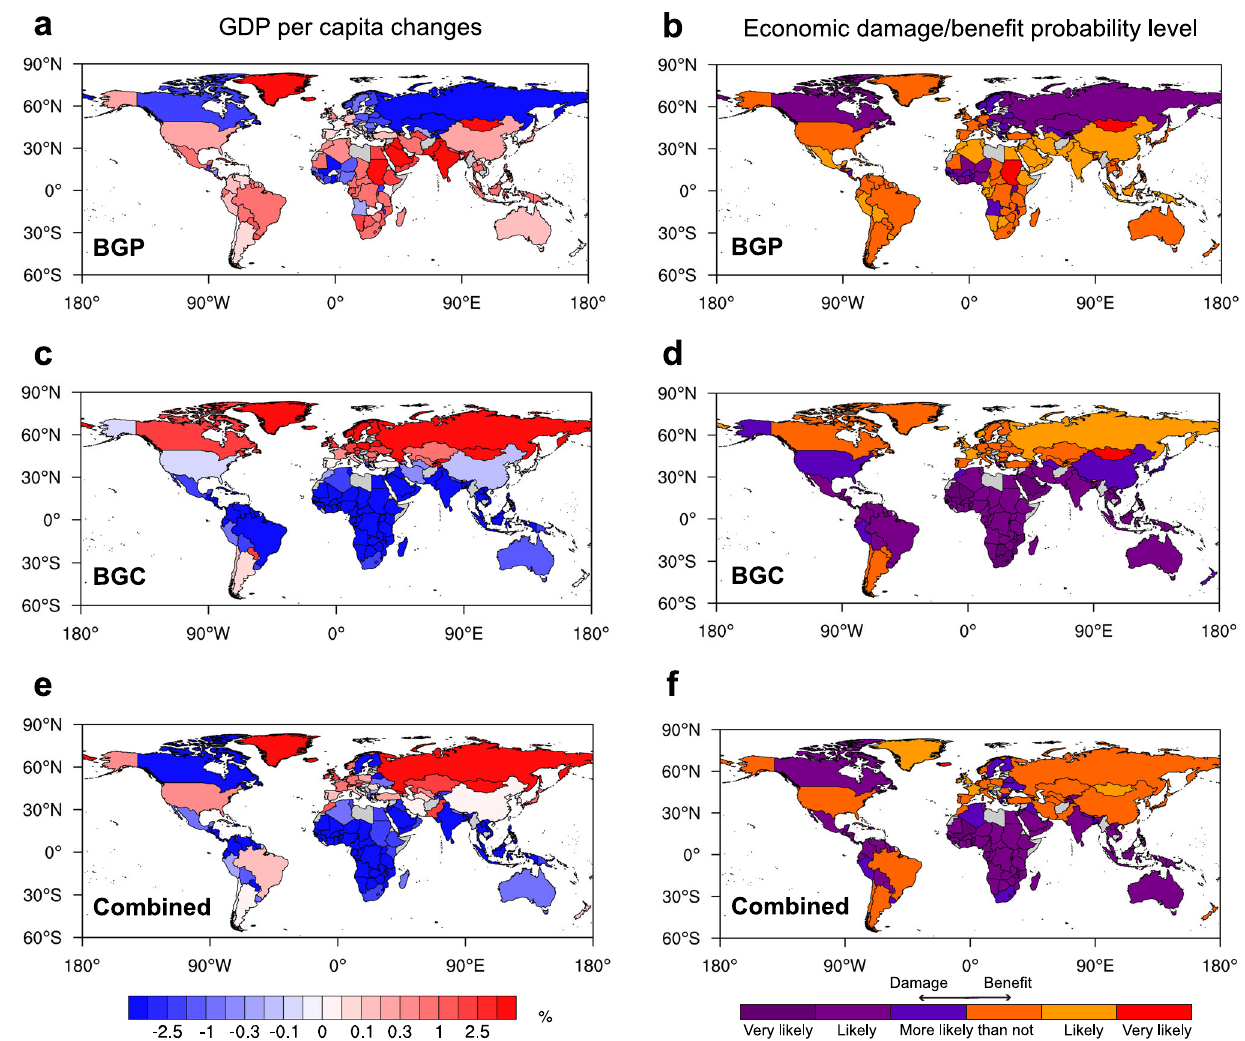
Fig. 5 Country-level cumulative economic impacts via annual-mean surface air temperature (SAT) changes from 1993 to 2012 due to biogeophysical (BGP) and biogeochemical (BGC) impacts of historical land-use and land-cover change (LULCC). a , c , e The ensemble median of the relative changes in GDP per capita (%) in 2012 induced by ( a ) BGP, ( c ) BGC, and ( e ) their combined impacts. b , d , f The corresponding probability level of the economic damage/bene fi t according to the IPCC uncertainty guidance 66 for ( b ) BGP, ( d ) BGC, and ( f ) their combined impacts. “ Very likely ” , “ Likely ” , and “ More likely than not ” indicate that more than 90%, two-thirds, and half of the members agree on the response, respectively. Countries and regions with missing values are shaded